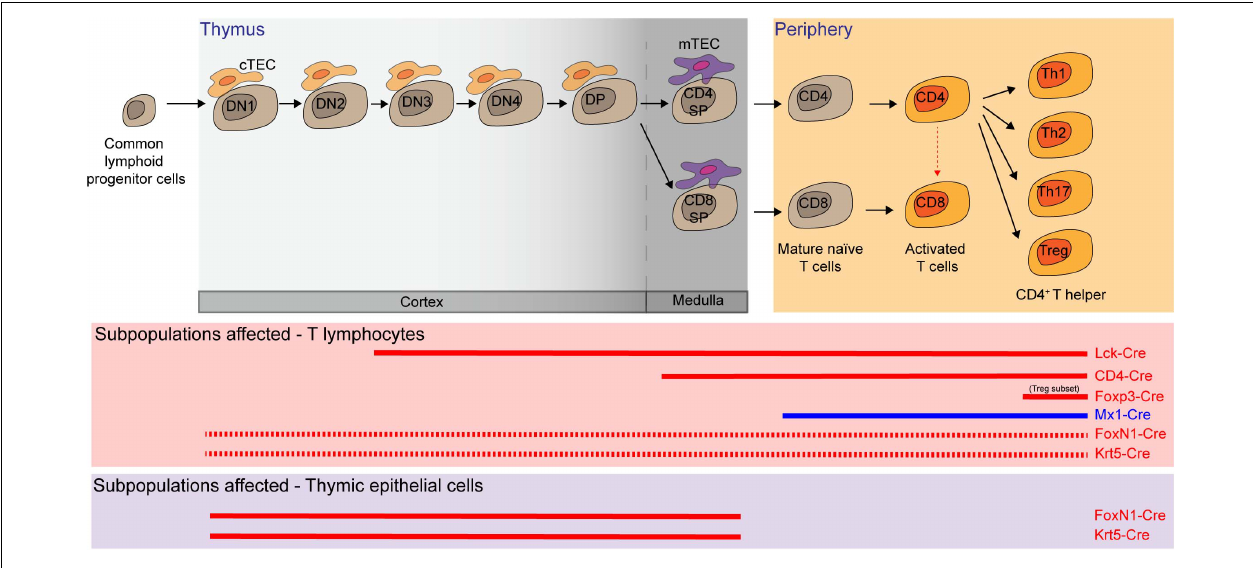
FIGURE 4 | Multiple T lymphocyte lineages and thymic epithelial cells (TEC) rely on Mcl-1 for survival. Conditional knockout (red solid line in the middle panel) and inducible knock-out (blue solid line) models showed that double negative 3 and 4 (DN3 and DN4), double positive (DP), CD4 single positive (SP), CD8 SP, mature T cells, activated T cells, and several subsets of T helper cells are dependent on Mcl-1 for their survival. FoxN1-Cre or Krt5-Cre mediated Mcl-1 deletion in TEC (red solid line in the bottom panel) substantially affected the survival of cortical TEC (cTEC) and medullary TEC (mTEC) and led to a significant decrease of all T cell subsets as the consequence of the disruption of thymic microenvironment (red dashed line).